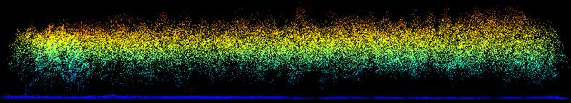
Figure 6. Normalized LAS (LiDAR Point Cloud)